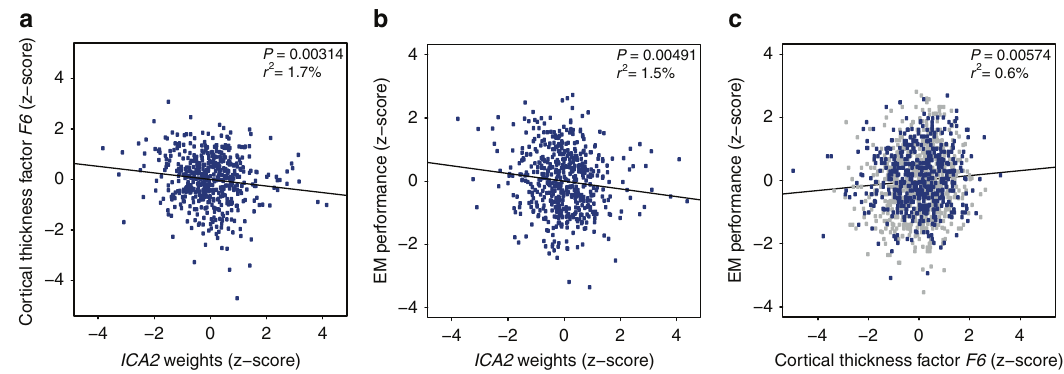
Figure 3 | Correlations between ICA2 weights, EM performance and cortical thickness score F6 . ( a ) Correlation between cortical thickness factor score F6 and ICA2 weights in the methylomic profiling sample. ( b ) Correlation between ICA2 weights and EM performance in the methylomic profiling sample. ( c ) Correlation between cortical thickness factor score F6 and EM performance in the combined sample ( N ¼ 1,234). Subjects from the methylomic profiling sample are shown in blue. ICA2 and the EM/imaging phenotypes are adjusted for chronological age effects.